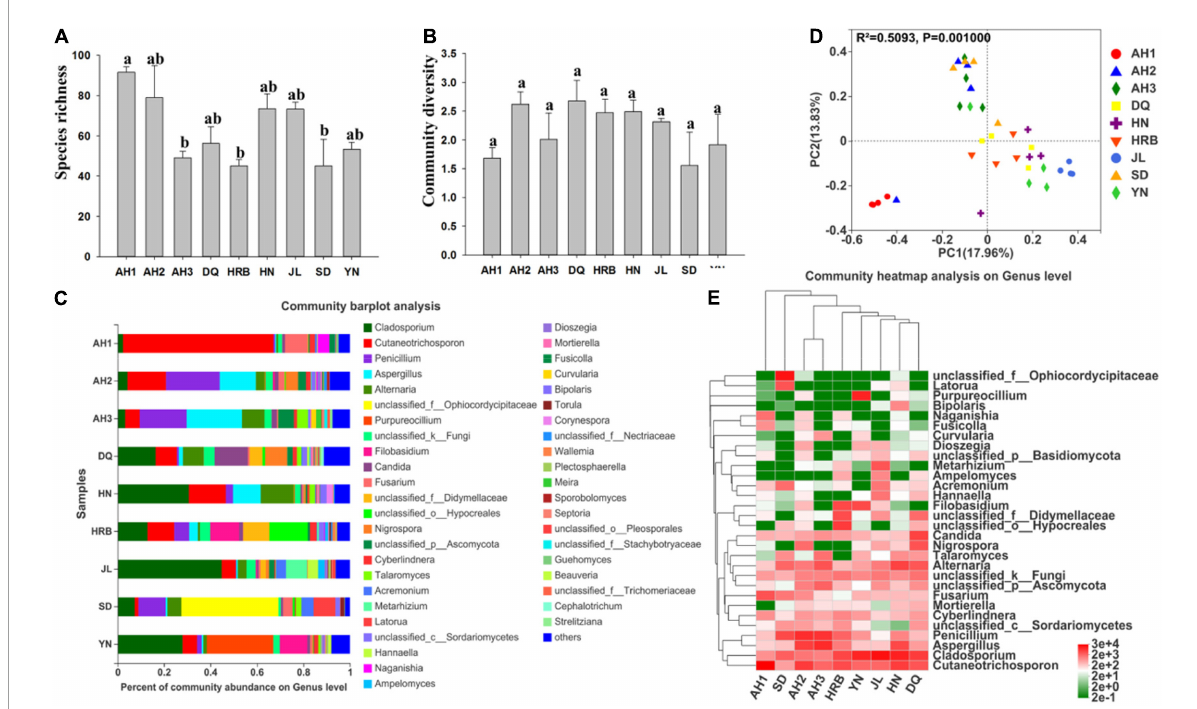
FIGURE6 Fungal community composition within and among the nine geographic populations of the hemp flea beetle P. attenuata in China. (A) Histogram of species richness (number of OTUs). (B) Histogram of community diversity measured by Shannon index. Letters above each population indicate significant differences (one-way ANOVA, Tukey test, P < 0.05, see Table 3 ) in the mean values. (C) Relative abundance of fungal genera in different populations. (D) Principal components analysis (PCoA) plots of fungal communities based on the Bray-Curtis distance. Each symbol or color represents a sample. The significant differences in beta diversities were analyzed using Adonis analysis with 999 permutations, P < 0.05. (E) Heatmap showing the relative abundance of top thirty genera. Hierarchical cluster analysis was based on the Bray – Curtis distance with average